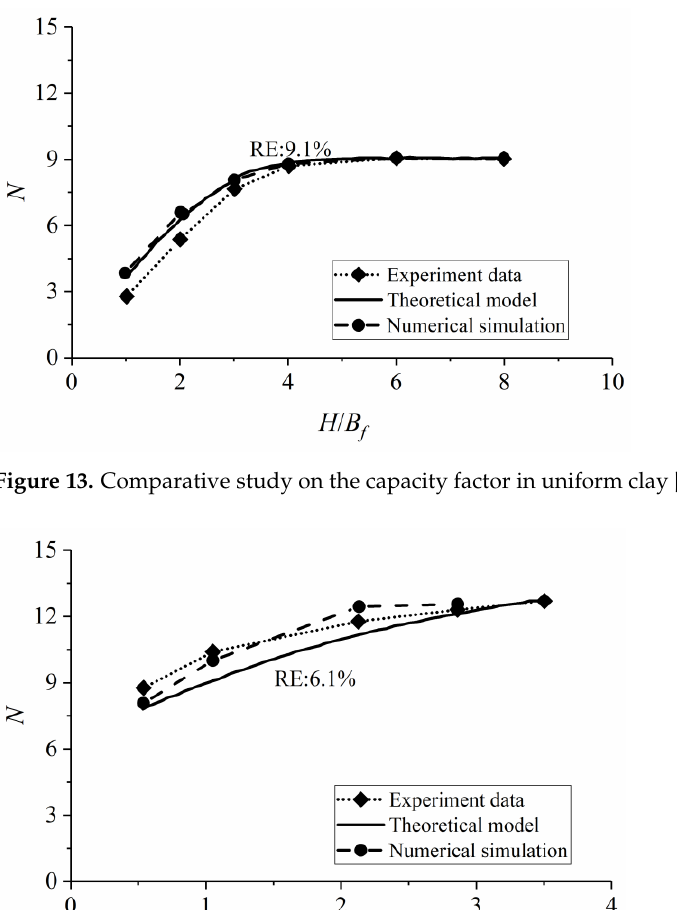
 = 27.8° (wedge-shaped anchor); ( d ) s